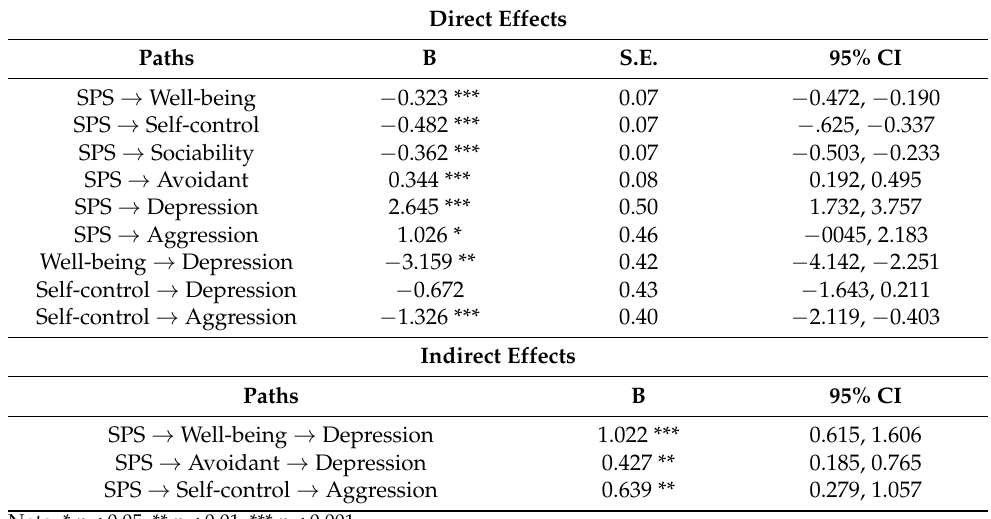
Table 2. Paths, unstandardized regression weights, and standardized errors in total sample.